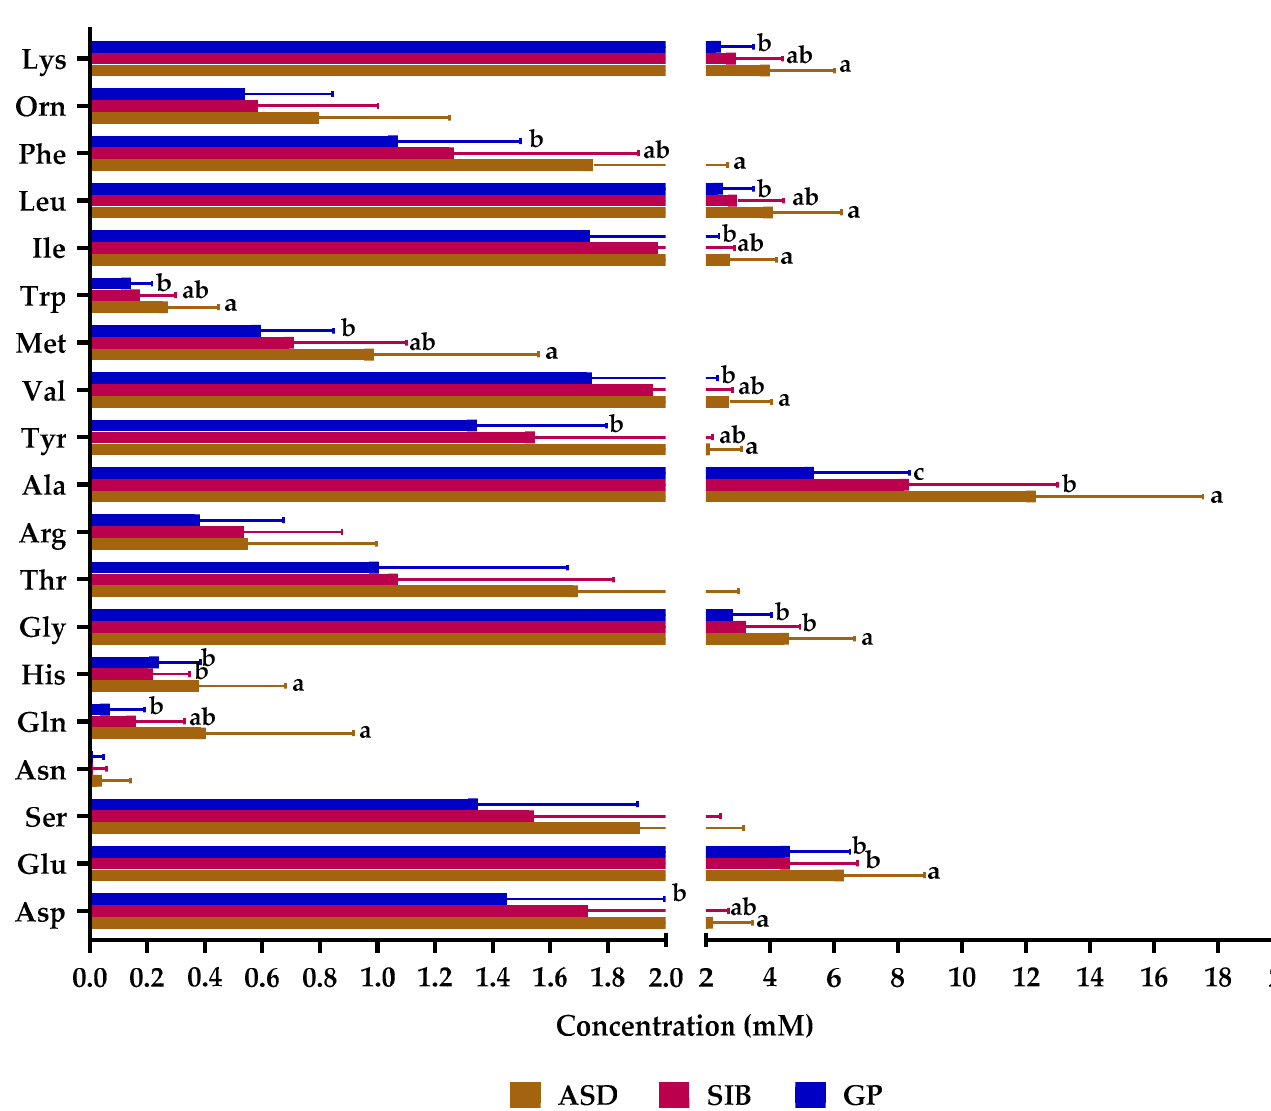
Figure 1. Fecal levels of amino acids in samples from autistic children (ASD), their siblings (SIB), and children from the general population (GP) in Tunisia. Asp: aspartate; Glu: glutamate; Ser: serine; Asn: asparagine; Gln: glutamine; His: histidine; Gly: glycine; Thr: threonine; Arg: arginine; Ala: alanine; Tyr: tyrosine; Val: valine; Met: methionine; Trp: tryptophan; Ile: Isoleucine; Leu: leucine: Phe: phenylalanine; Orn: Ornithine; Lys: lysine. Bars represent mean values and horizontal lines on the bars represent standard deviation. Different letters (a, b, ab, c) indicate significant differences among groups of children for each amino acid ( p < 0.05).